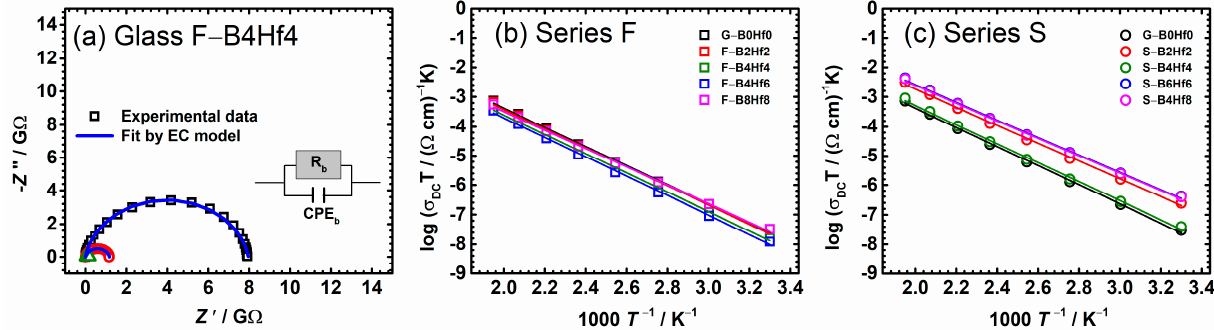
Figure 1. ( a ) Complex impedance plots at different temperatures and ( b , c ) Arrhenius plots of direct current (DC) conductivity (log( σ DC T ) vs. 1000/ T ) for individual samples from ( b ) F– and ( c ) S–glass series. The corresponding equivalent circuit in ( a ) used for fitting the data is shown in the inset. Open squares denote experimental values; a solid black line corresponds to the best fit. Solid lines in ( b , c ) represent the least-square linear fits to experimental data. The error bars are, at most, of the order of the symbol size.